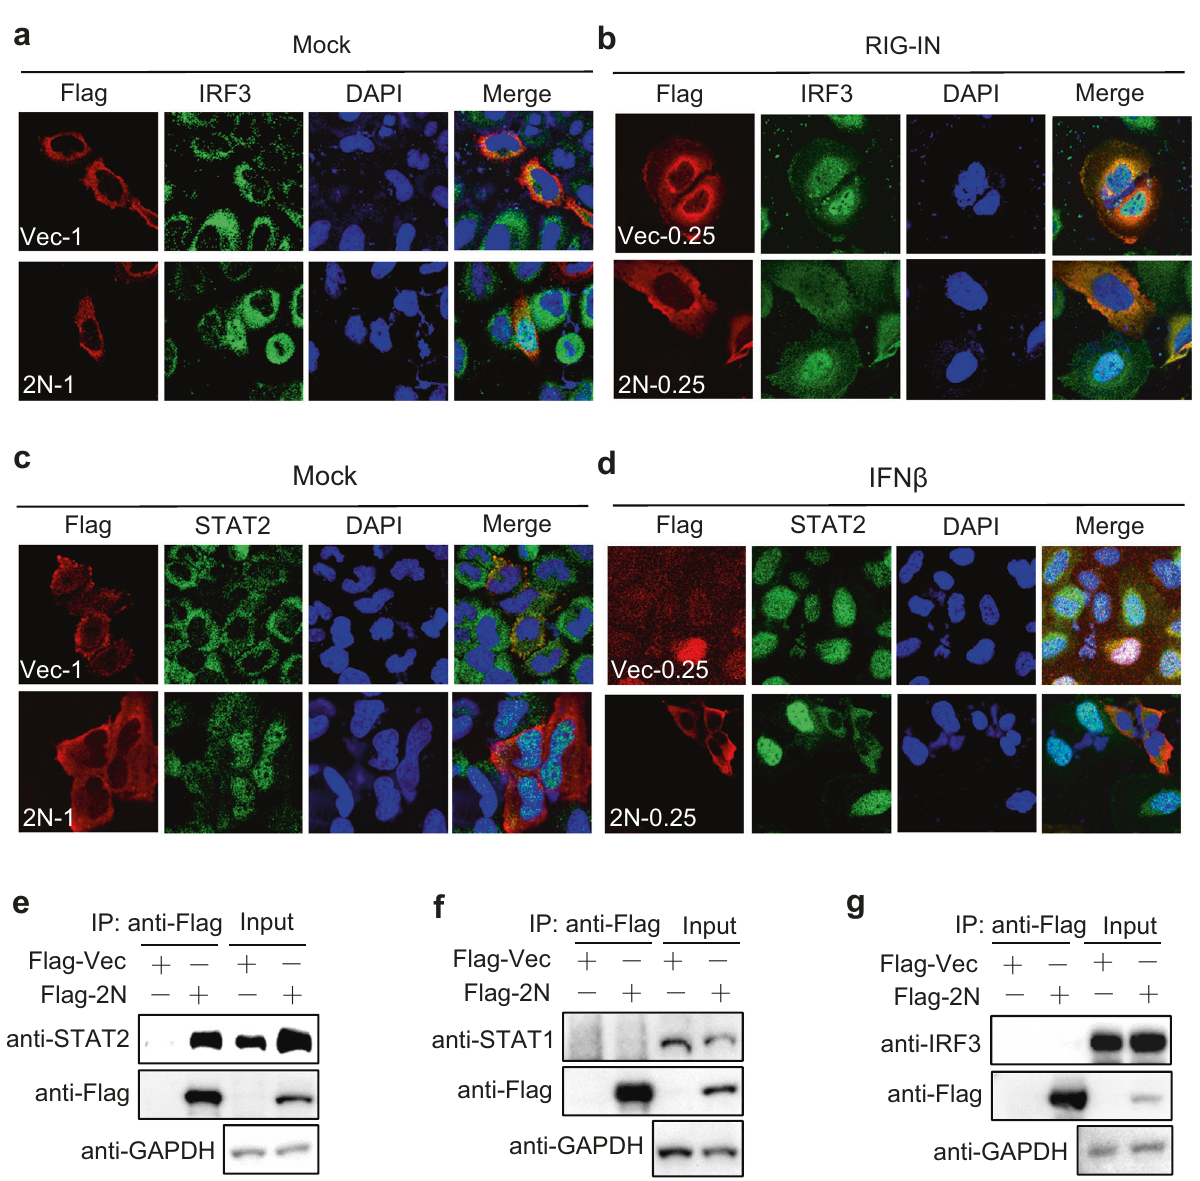
Fig. 3 The interaction of 2N and IRF3, STAT1, or STAT2. a HepG2 cells were transfected with 1 μ g Flag-tagged SARS-CoV-2 N (Flag-2N) or vector plasmids in 24-well plate. At 24 hpt, cells were subjected to immuno fl uorescence with anti-IRF3 and Flag antibodies. b HepG2 cells were transfected with 0.25 μ g Flag-2N or vector together with RIG-IN. At 24 hpt, cells were subjected to immuno fl uorescence. Green: IRF3 signal; Red: 2N signal; Blue: DAPI (4, 6-diamino-2-phenyl indole, nuclei staining). Merge indicate the merged red, green, and blue channels. c HepG2 cells were transfected with 1 μ g Flag-2N or vector plasmids. At 24 hpt, cells were subjected to immuno fl uorescence with anti-STAT2 and Flag antibodies. d HepG2 cells were transfected with 0.25 μ g Flag-2N or vector for 24 h, then cells were treated with IFN- β for 30 min, and subjected to immuno fl uorescence. Green: STAT2 signal; Red: 2N signal; Blue: DAPI. e-g HEK293T cells were transfected with the plasmids as indicated. At 24 hpt, anti-Flag immunoprecipitates were analyzed by immunoblot with STAT2 ( e ), STAT1 ( f ) and IRF3 ( g )